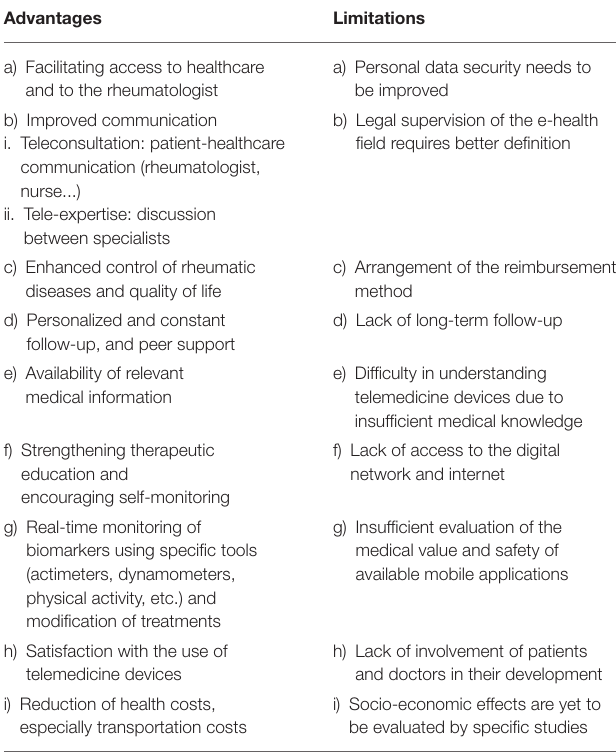
TABLE 1 | The advantages and limitations of telemedicine in